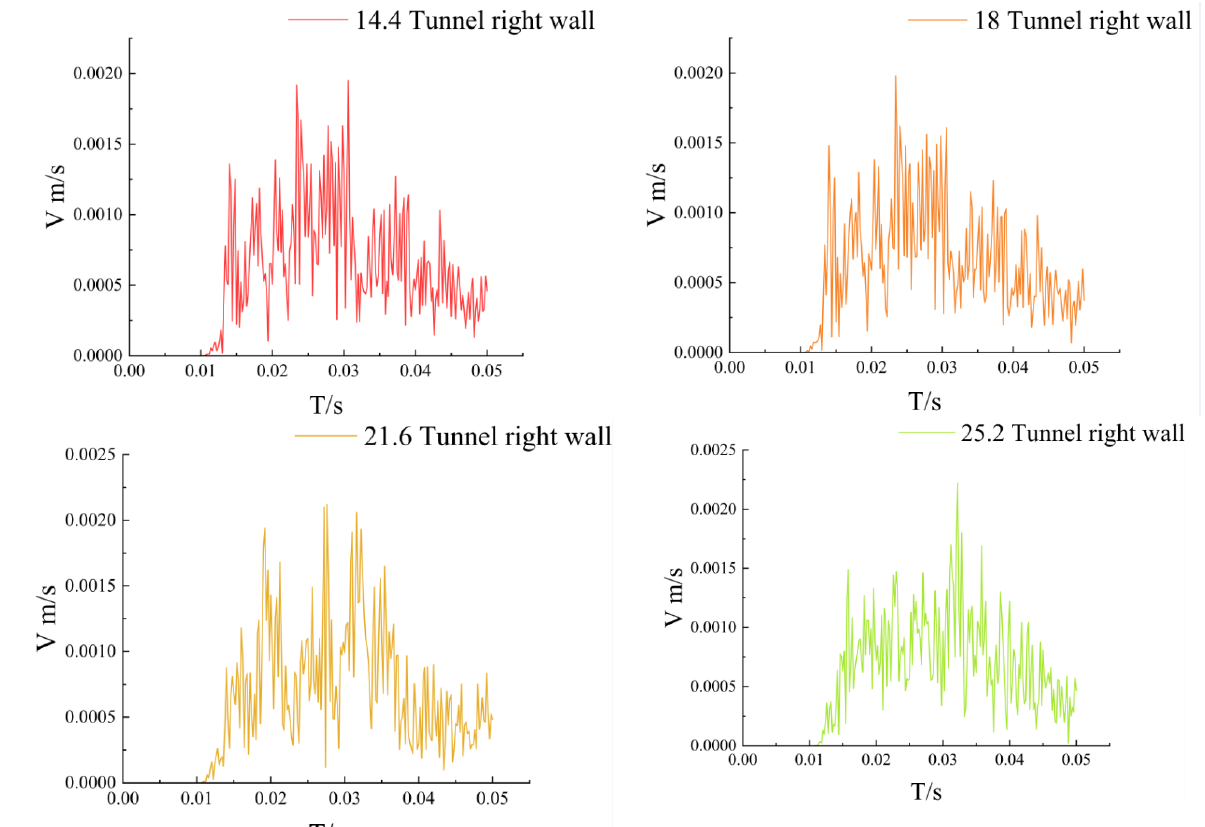
Table 8. Peak particle velocity and position of vibration velocity with the same explosive